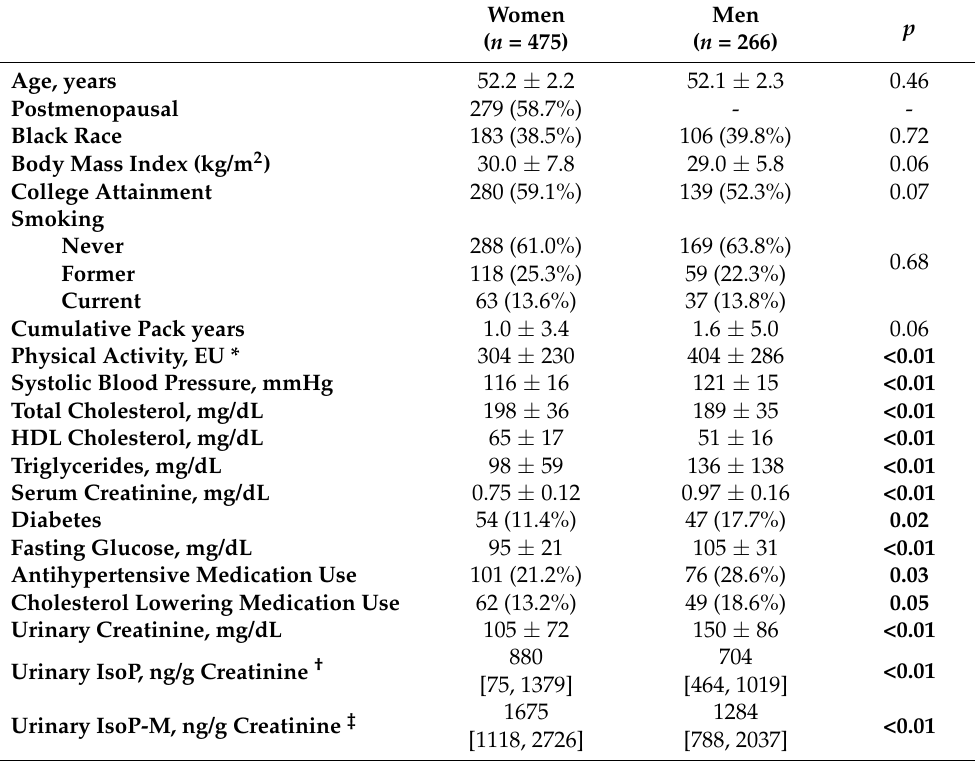
Table 1. Characteristics of participants at CARDIA Year 25